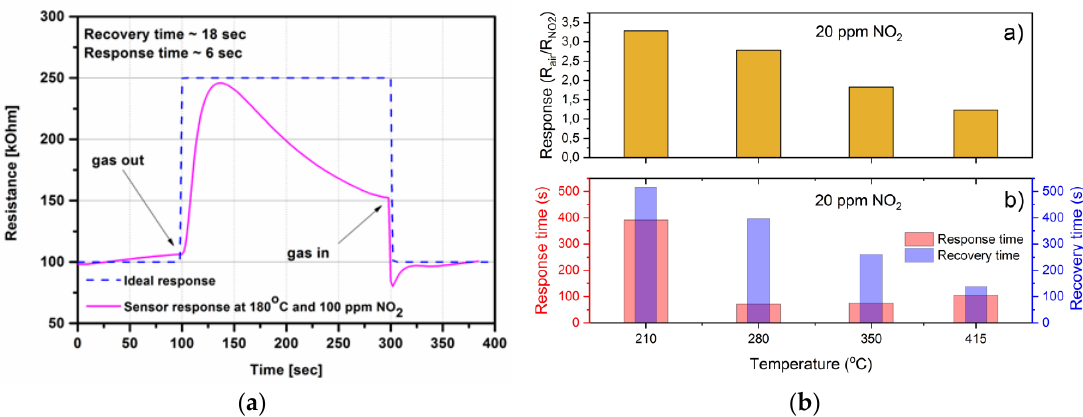
Figure 4. The copper oxides under exposure to nitrogen dioxide: ( a ) resistance change of the amorphous CuO thin film under exposure to 100 ppm of NO 2 at 180 °C and 50% RH (Reprinted with permission from [32]. Copyright 2014 IEEE); ( b ) responses and response/recovery time (s) of nanocrystalline CuO thin films under exposure to 20 ppm NO 2 at various temperatures and 50% RH. (Reprinted with permission from [70]. Copyright 2018 IEEE).